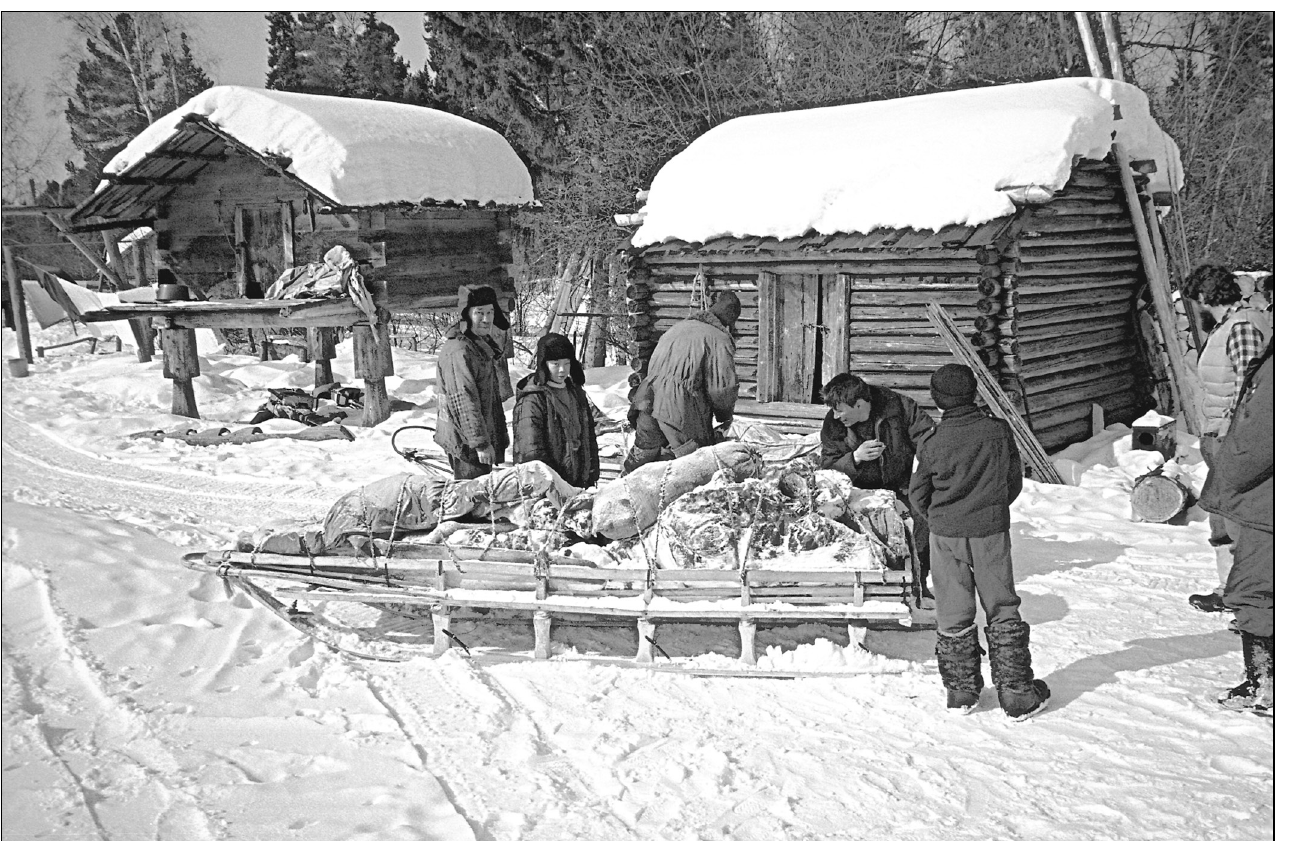
Figure 4 Hunters return to their yurt settlement with butchered elk carcasses on two cargo sledges, March